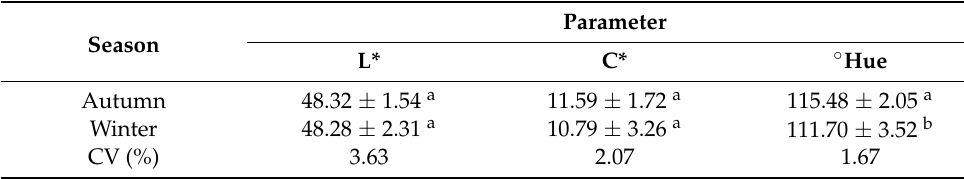
Table 4. Mean values ± standard deviation of instrumental color parameters L*, C*, and ◦ Hue of Pereskia aculeata Mill. leaves in the autumn and winter